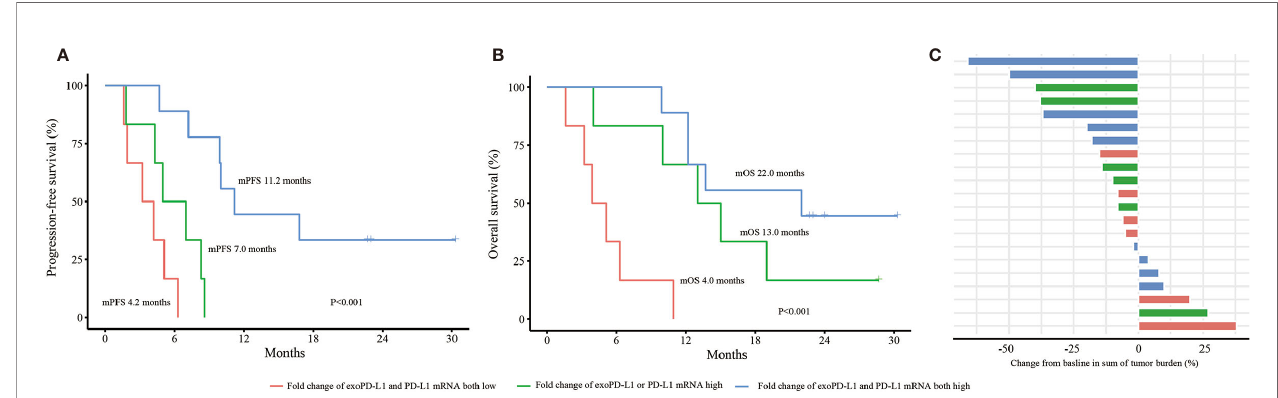
FIGURE 5 | Ef fi cacy and OS analyses based on the combination of PD-L1 mRNA and exoPD-L1 expression in the 21 NSCLC cohort. (A) PFS analysis based on the combination of two biomarkers. (B) OS analysis based on the combination of two biomarkers. (C) bOR of each patient strati fi ed by the combination of two biomarkers. OS, overall survival; exoPD-L1, exosomal PD-L1; PFS, progression-free survival; bOR, best objective response. P values were calculated by